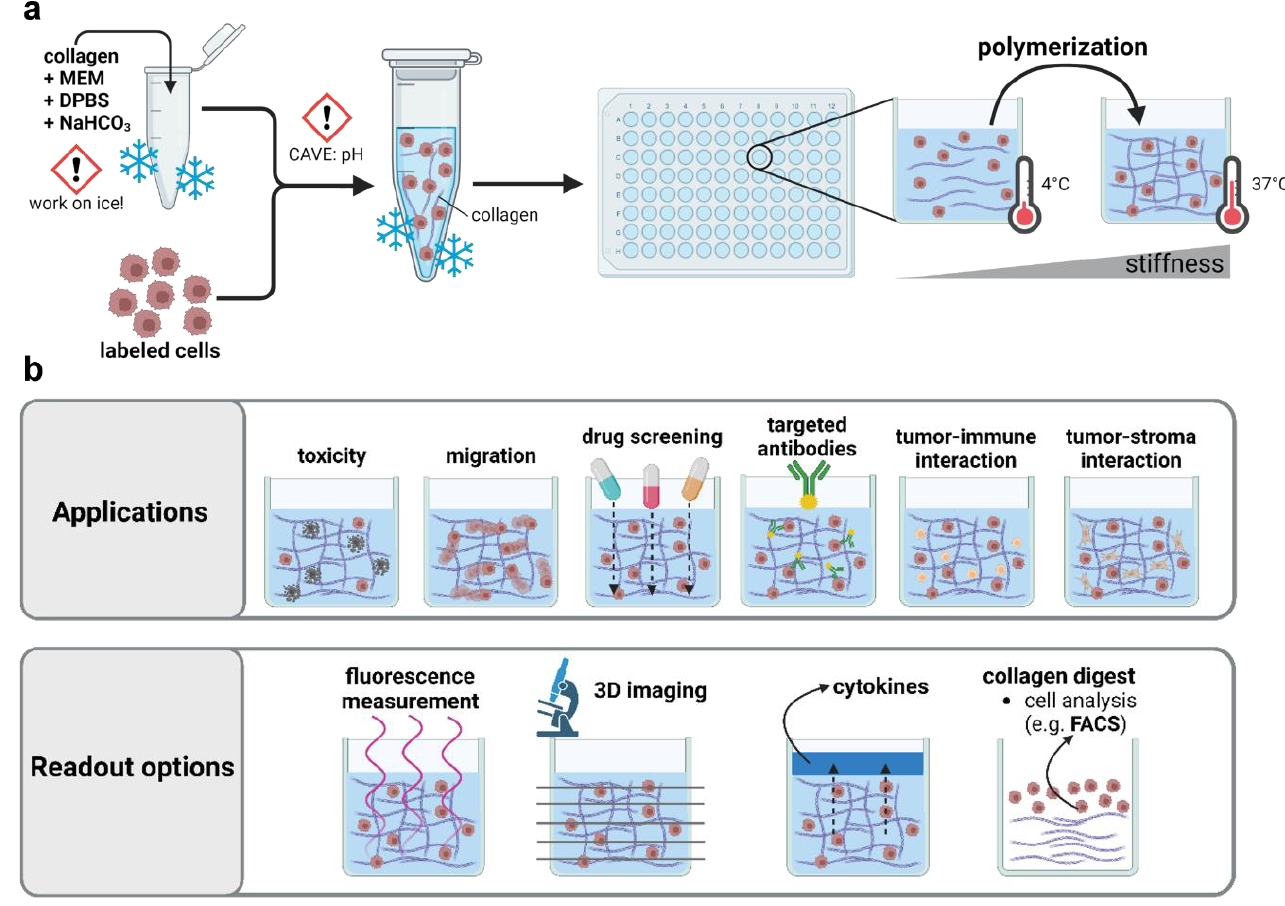
Figure 1. Applications of 3D collagen-based hydrogel models in preclinical research. ( a ) Schematic overview of collagen hydrogel preparation; ( b ) application and read-out options of three-dimensional hydrogel models. MEM = minimum essential medium; DPBS = Dulbecco’s phosphate-buffered saline; NaHCO 3 = sodium